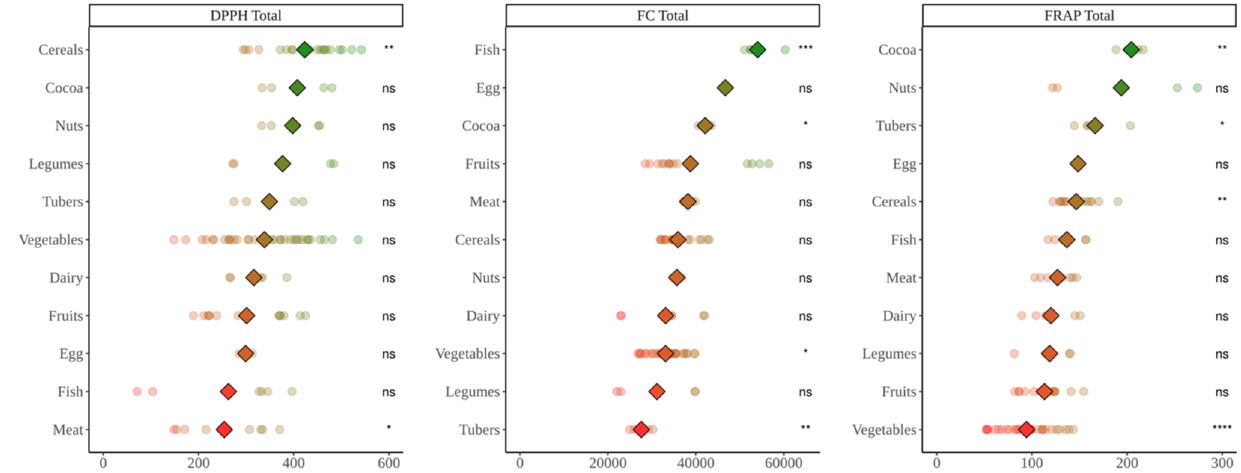
Figure 3. In vitro digestion values + in vitro fermentation values of food obtained after in vitro fermentation of selected foods with fecal material from lean children. DPPH expressed as mmol Trolox equivalents/kg(L) of food; Folin-Ciocalteu (FC) expressed as mg equivalents of gallic acid/kg(L) of food; FRAP expressed as mmol Trolox equivalents/kg(L) of food. Diamonds represent the mean antioxidant capacity of each group. Dots represent the antioxidant capacity of each food within the group. Statistical analysis was performed via Kruskal Wallis test. Each of the groups were compared to the average of all of them (i.e., base-mean). Statistic labels: *— p < 0.05, **— p < 0.01, ***— p < 0.001, ****— p < 0.0001, ns—not significant.